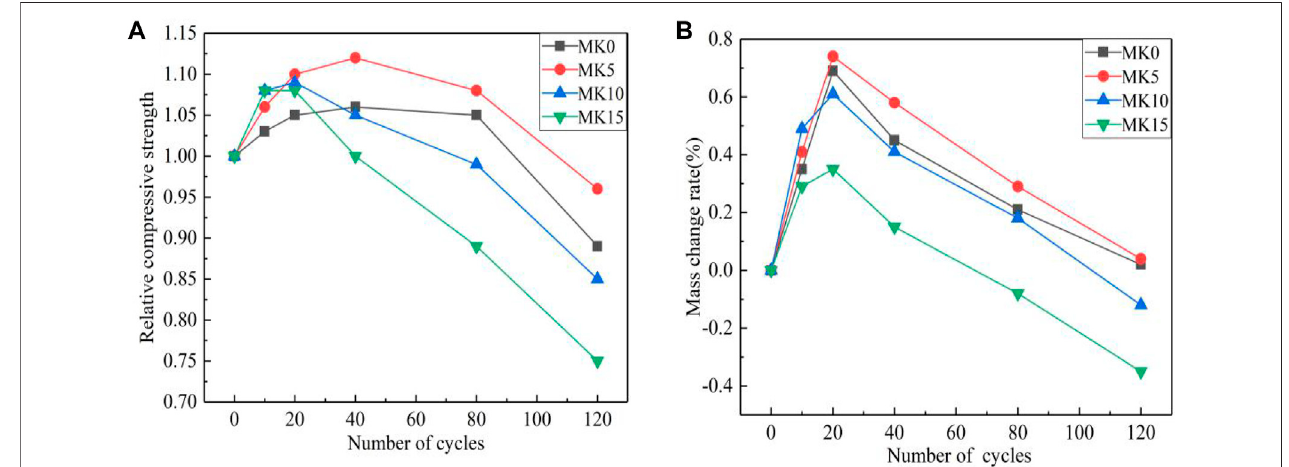
FIGURE 2 | Changes in physical properties of concrete: (A) Relative compressive strength; (B) Mass change rate.